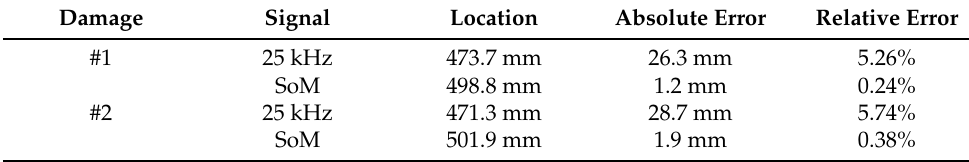
Figure 16. SoM damage signals from damaged FE model: ( a ) #1, ( b ) #2. Table 4. FE damage localization